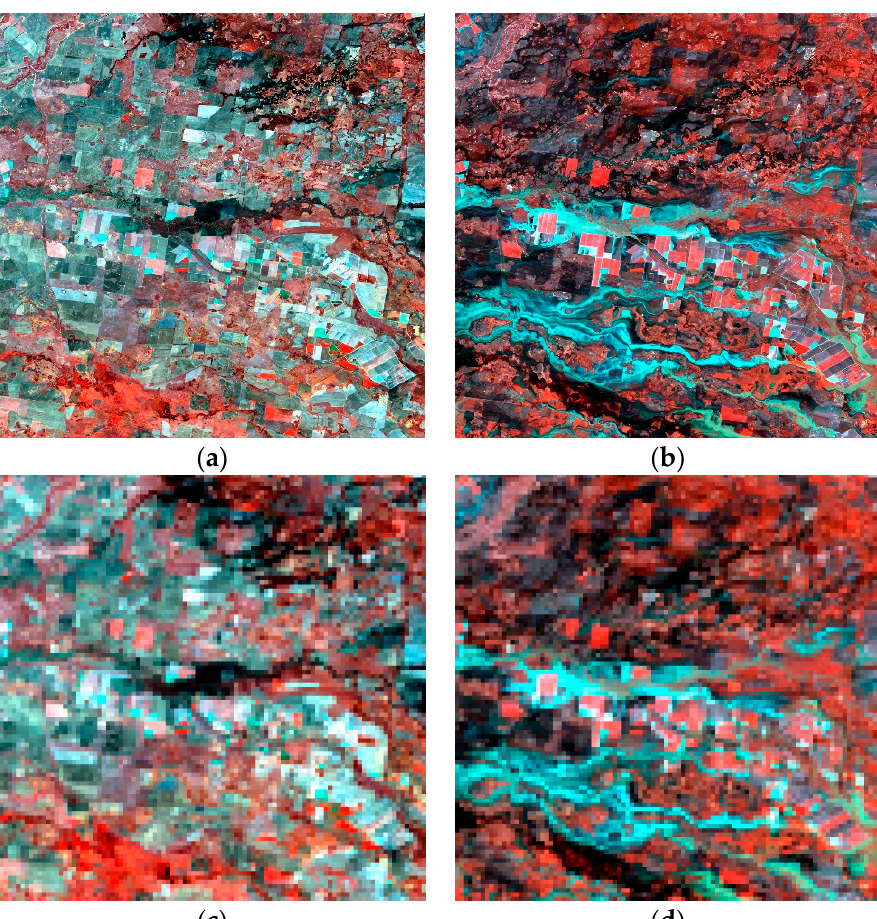
Figure 4. Dataset of Gwydir: real Landsat-5 acquired on 26 November 2004 ( a ), and 12 December 2004 ( b ), ( c ) and ( d ) are simulated MODIS-like images with a degrading factor of 16.